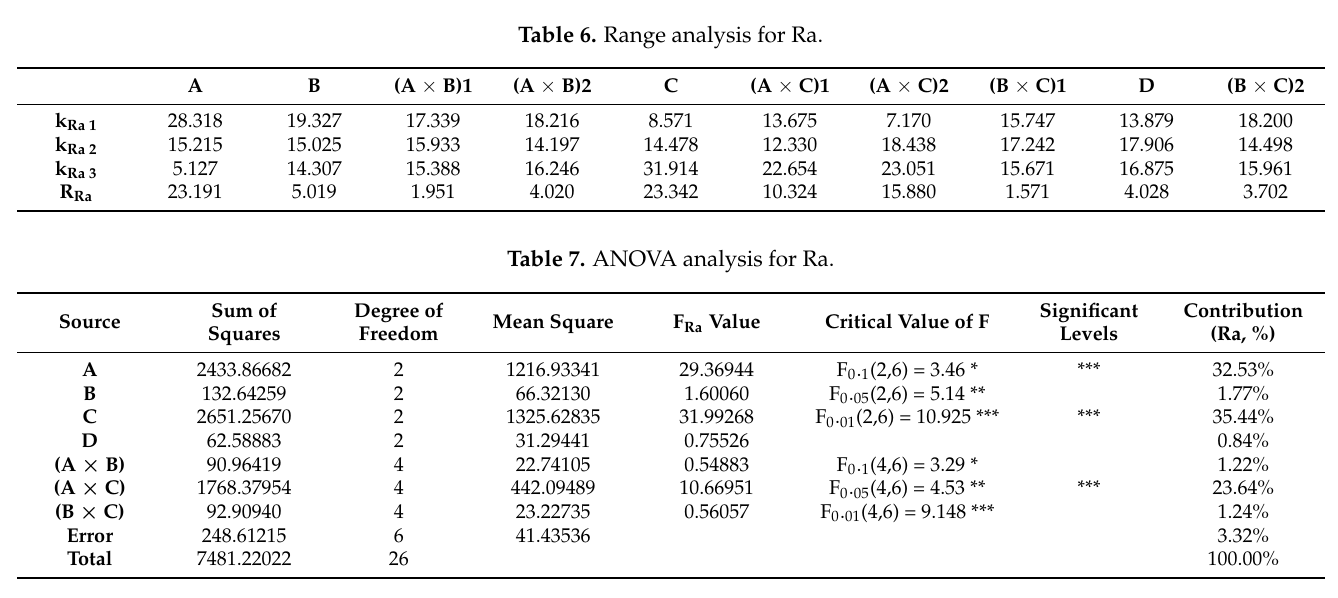
Table 8. Range analysis for TTV.